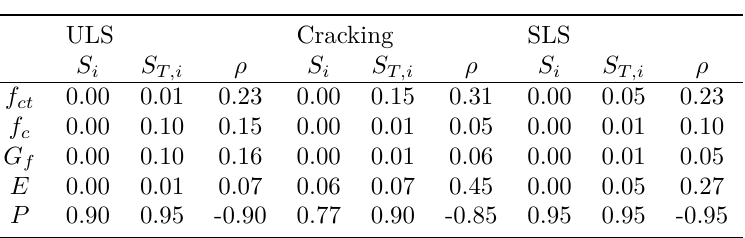
Table 3. Results of sensitivity analysis via PCE. ρ represents non-parametric rank order correlation by Spearman coefficients, S first-order Sobol indices and S total-order Sobol i T,i